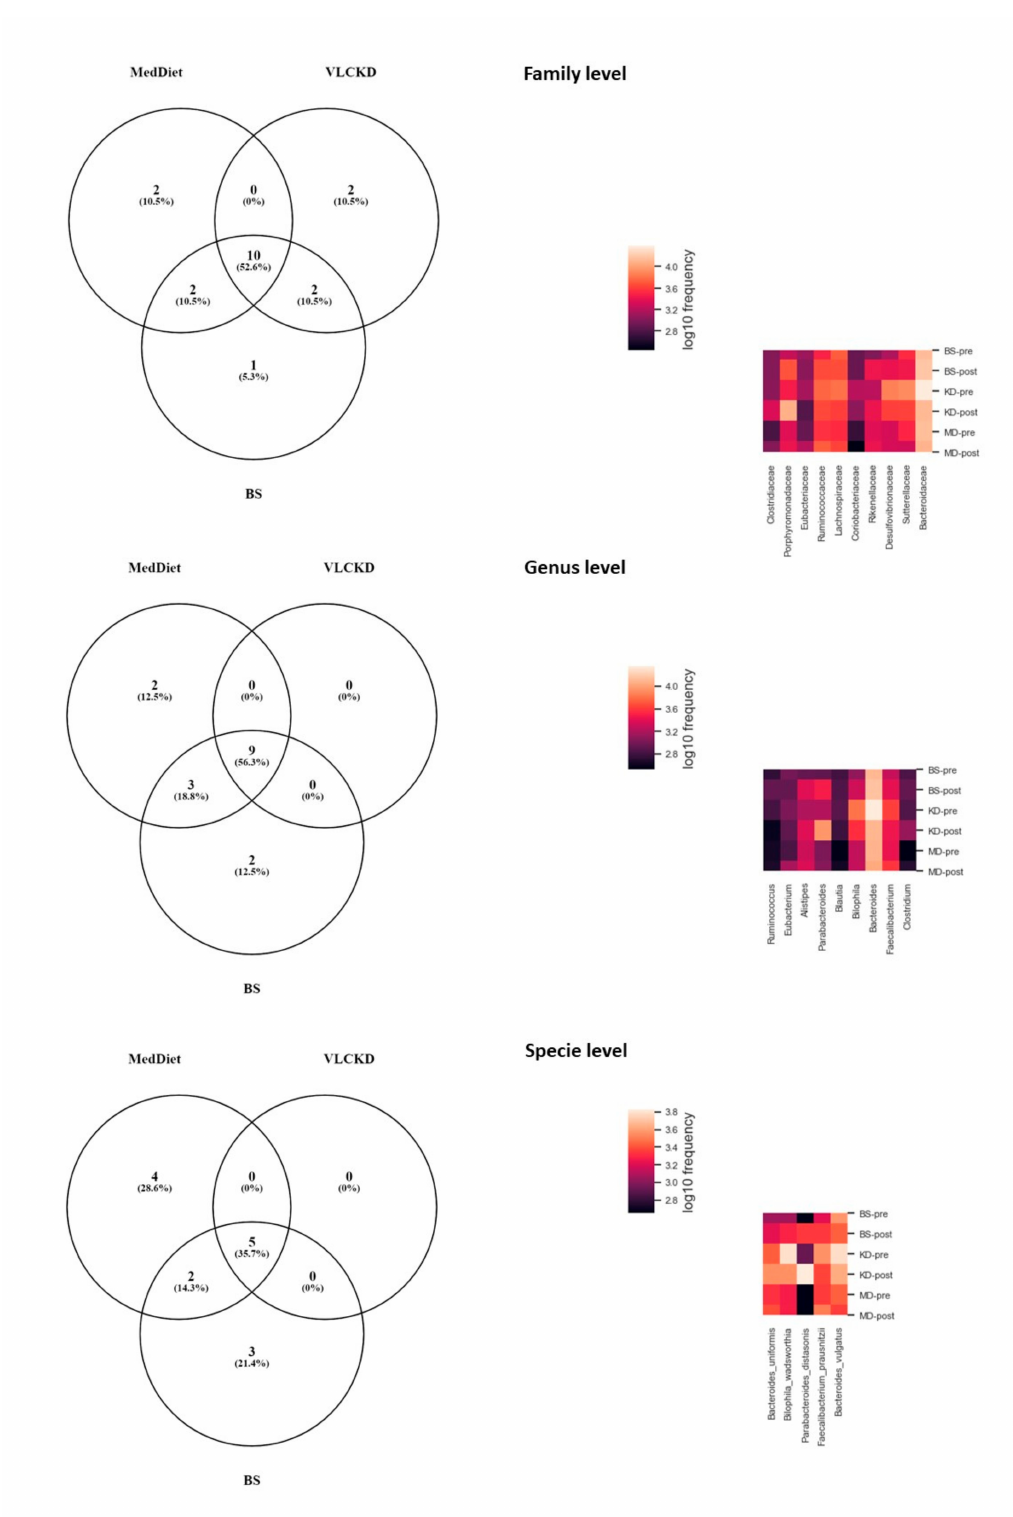
Figure 3. Venn diagram of the core microbiomes shared among the 85% of the samples at different taxonomic level. MD-pre: Mediterranean Diet at baseline. MD-post: Mediterranean Diet at the end of the intervention ( n = 21). BS-pre: Bariatric surgery at baseline. BS-post: Bariatric surgery at the end of the intervention ( n = 22). VLCKD-pre: very-low calorie ketogenic dietat baseline. VLCK-post: very-low calorie ketogenic diet at the end of the intervention ( n =